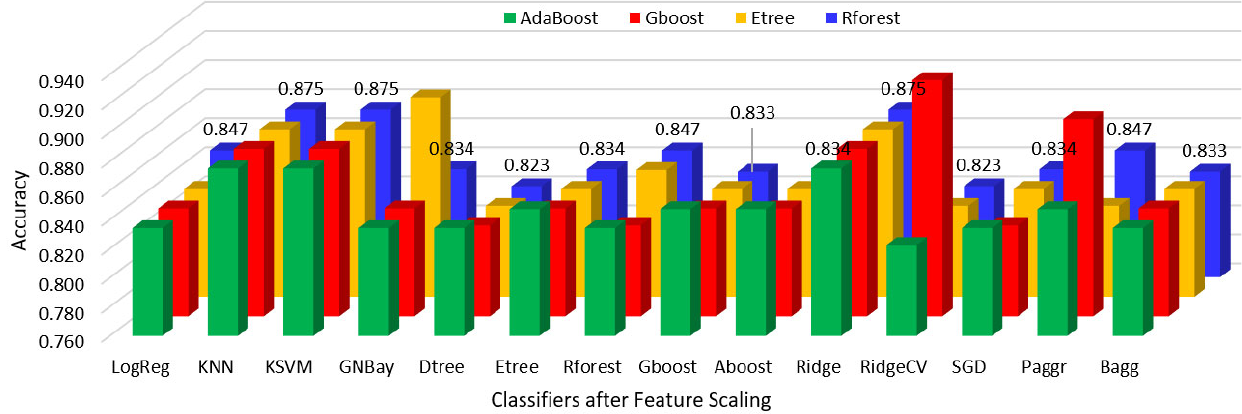
Figure 10. Classifier feature importance performance of all classifiers after scaling.